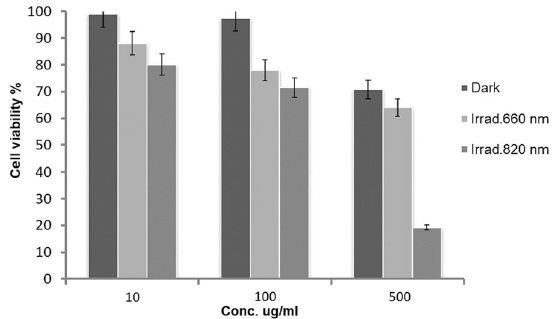
Fig. 10 Dark and photocytotoxicity of SM-NP-Tw at different melanin